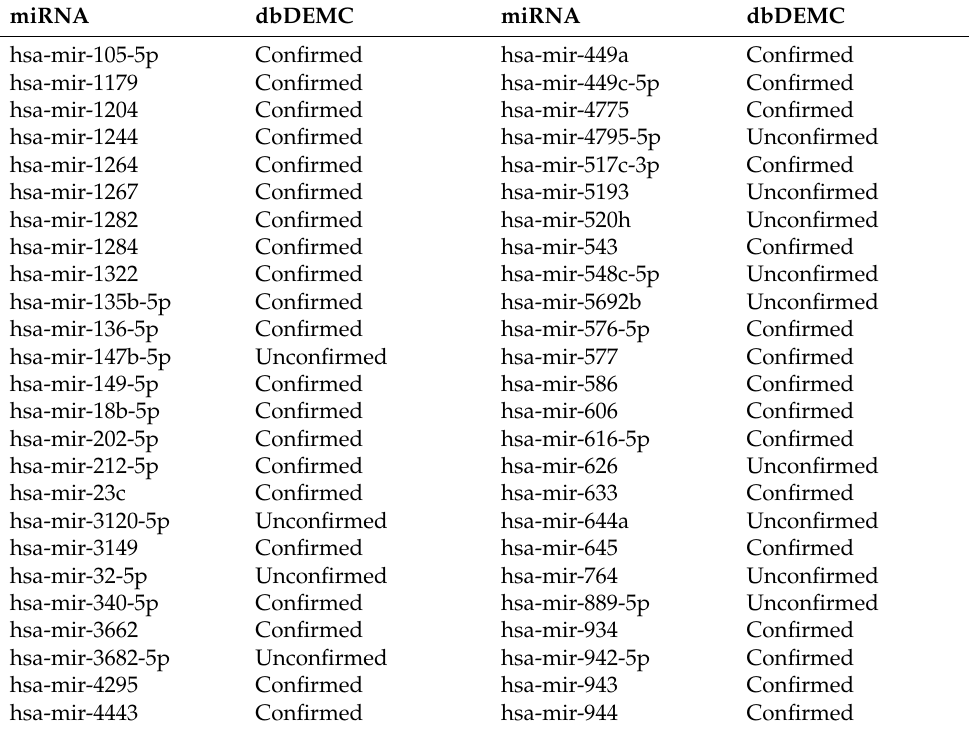
Table 4. Kidney neoplasm associated miRNA Top 50 predicted by hmdd v3.2.